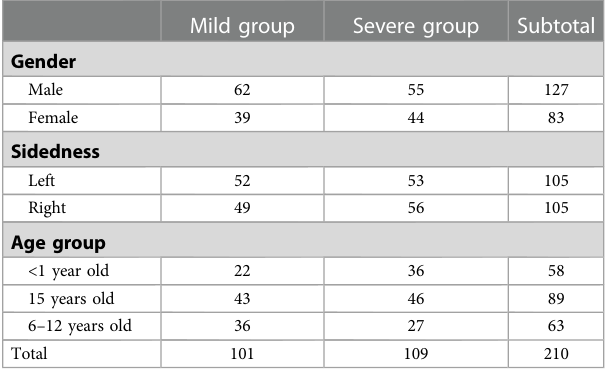
TABLE 1 Demographic information and baseline characteristics.